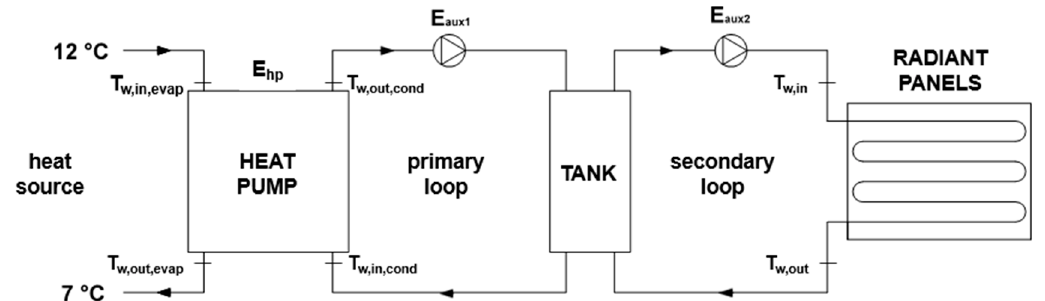
Figure 9. Simplified layout of the considered heating system.